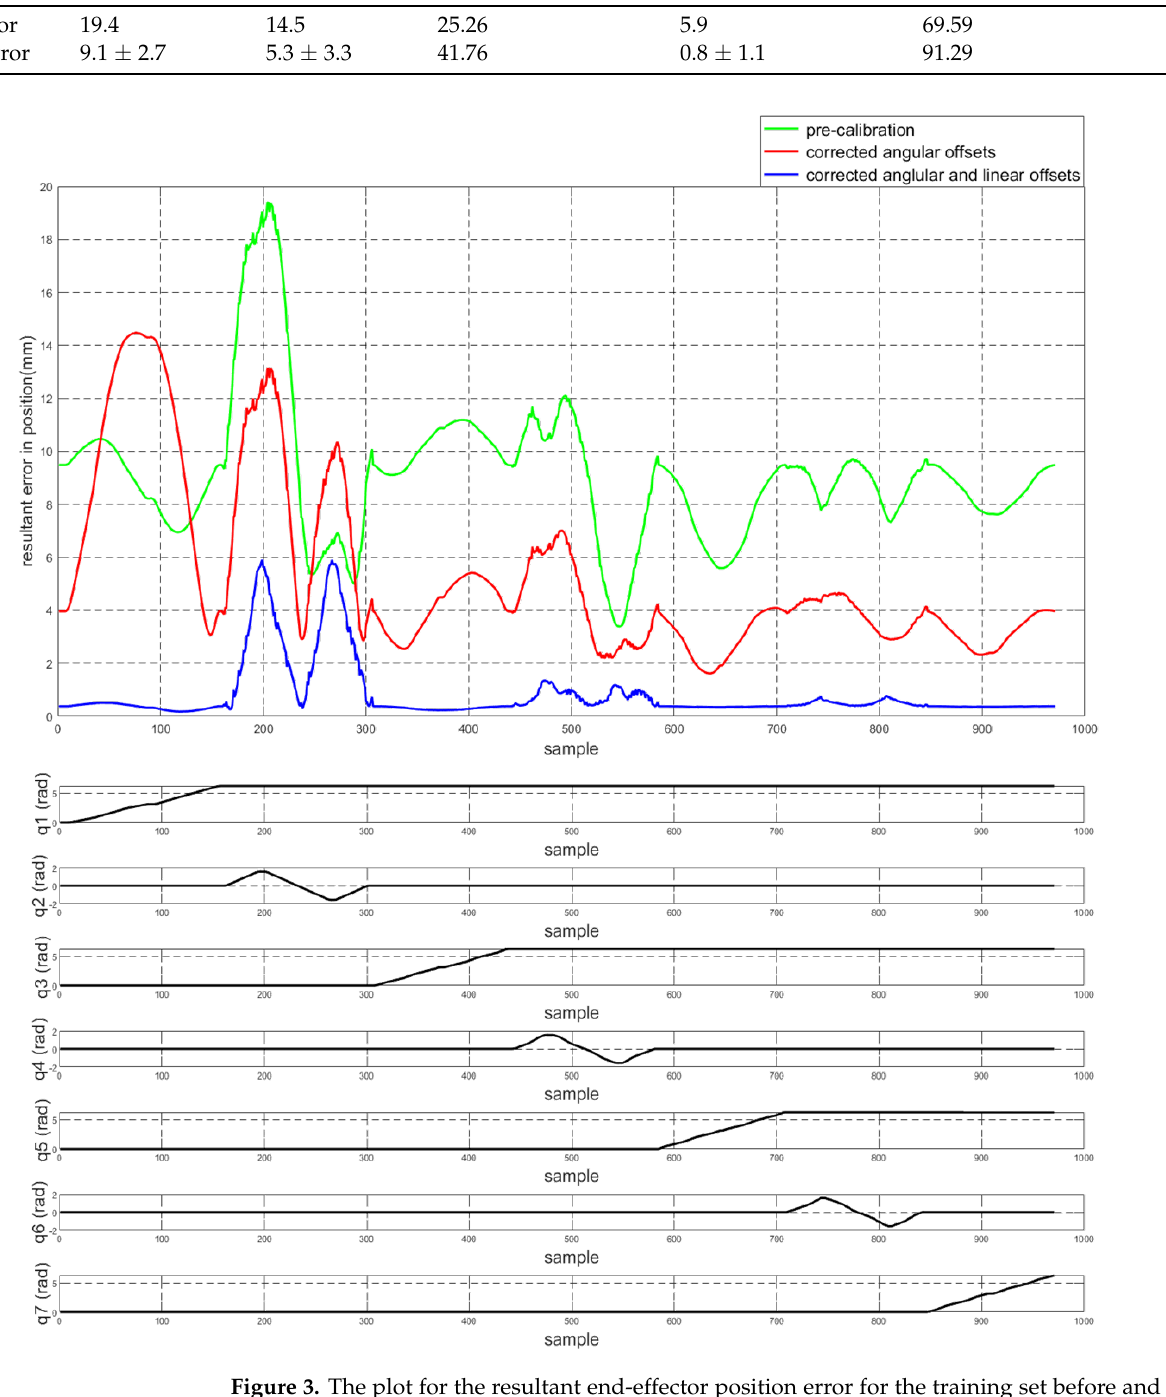
Figure 3. The plot for the resultant end-effector position error for the training set before and after calibration ( top ) and the motion of each of the robot joints during the training set generation ( bottom